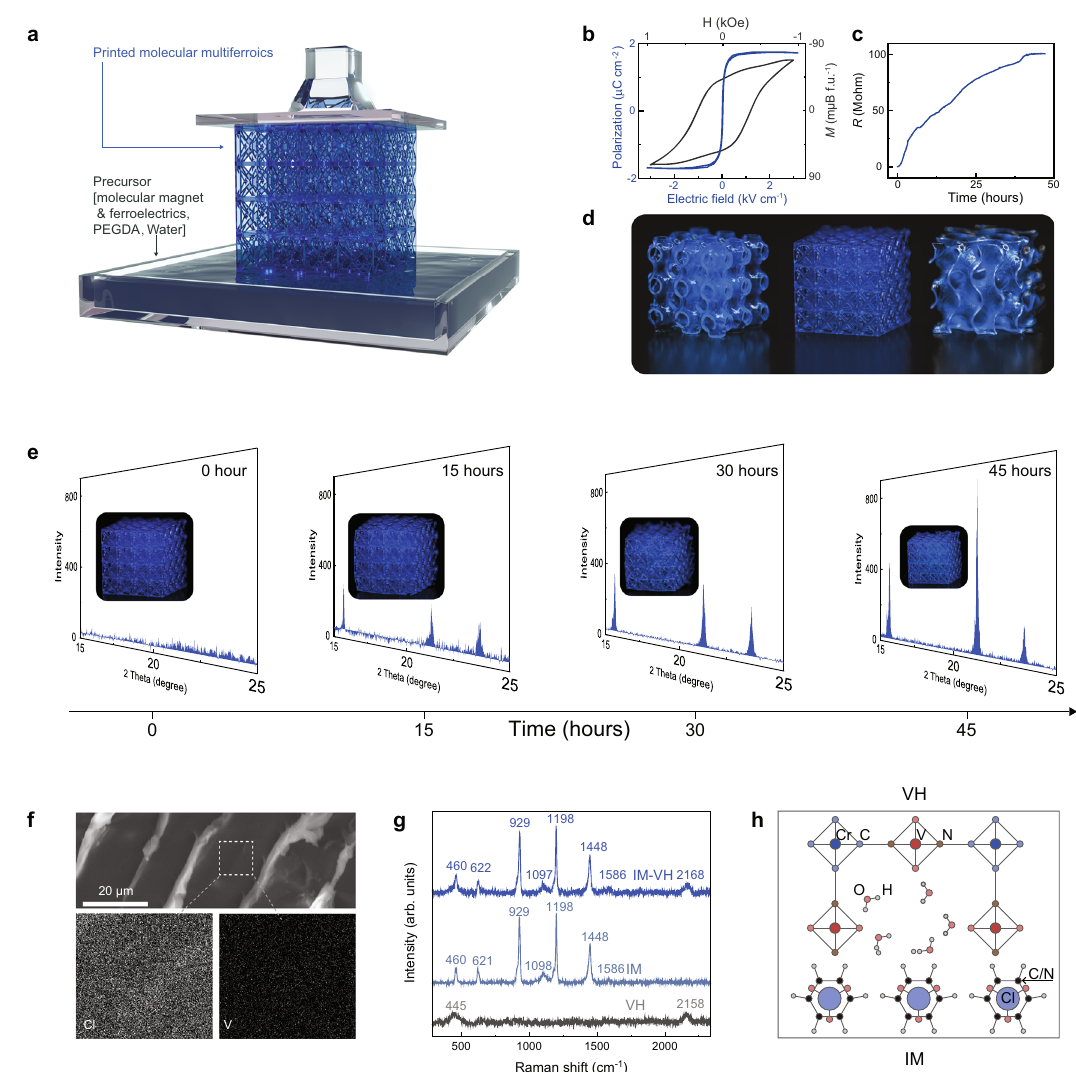
Fig. 3 3D printing and crystallization of multiferroic molecular heterogeneous solid. a Schematic diagram for manufacturing multiferroic composite (Lattice structure) by the SLA method. The digital projection printing setup (Supplementary Fig. 4) was utilized to project dynamic digital masks on the photocurable polymer composite solution. The UV light used has a wavelength of 385 nm and the control of image projection was achieved through a dynamic micromirror device. b Room-temperature polarization vs electric fi eld (P-E) loop for molecular ferroelectric ImClO 4 at 5 Hz. Room-temperature M- H loop for molecular magnetic MA. c Time dependence of resistance measurement during the crystallization process. d Optical images for 3D printed IM- VH with different complex geometric structures (Schwarz primitive structure, lattice structure and minimal surface Structures, 25 × 25 × 25 mm 3 ). e Room- temperature in situ XRD measurement during the crystallization process. Insets show the optical images for the printed sample during the crystallization process. f SEM image for IM-VH, bright area indicates the PEGDA scaffold, and the dark area represents IM-VH. EDS mapping for V and Cl elements. g Room-temperature Raman spectra for IM-VH, IM, and VH. h Schematic diagram for the interface between IM and